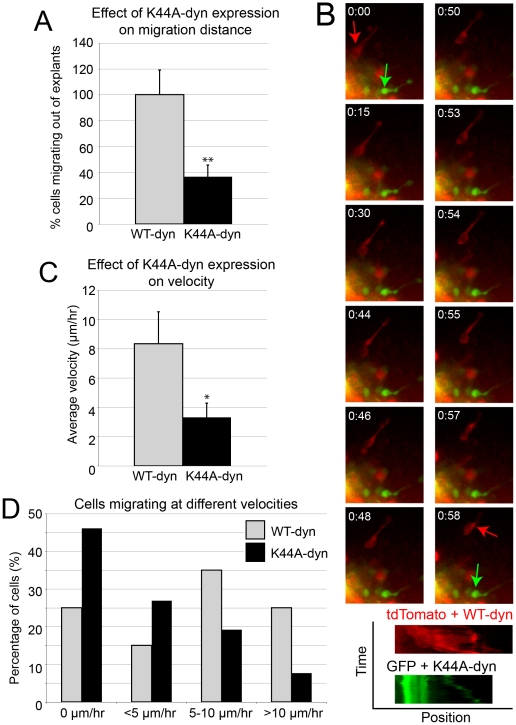
Dominant negative dynamin impairs SVZa neuron migration.(A) Fewer cells migrate out of explants expressing K44A-dyn compared to explants expressing WT-dyn. (B) Example time-lapse series of cells in the same culture expressing either WT-dyn with tdTomato (red arrow) or K44A-dyn with GFP (green arrow). Kymographs showing position (x-axis) over time (y-axis) highlight movement of the cell body. Leading process movement can be seen in the K44A-dyn/GFP cell. See Movie S1. (C) K44A-dyn expressing cells that migrate out of explants have a significantly lower migration rate than WT-dyn expressing cells. (D) A greater percentage of K44A-dyn cells do not migrate, or have slower rates than those expressing WT-dyn. Data presented as mean±SEM, *p<0.05, **p<0.01, Student's t-test.